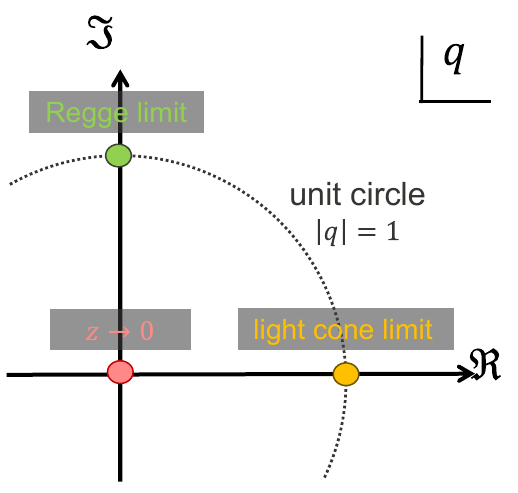
Figure 10 . The relation between cross ratio z and elliptic nome q